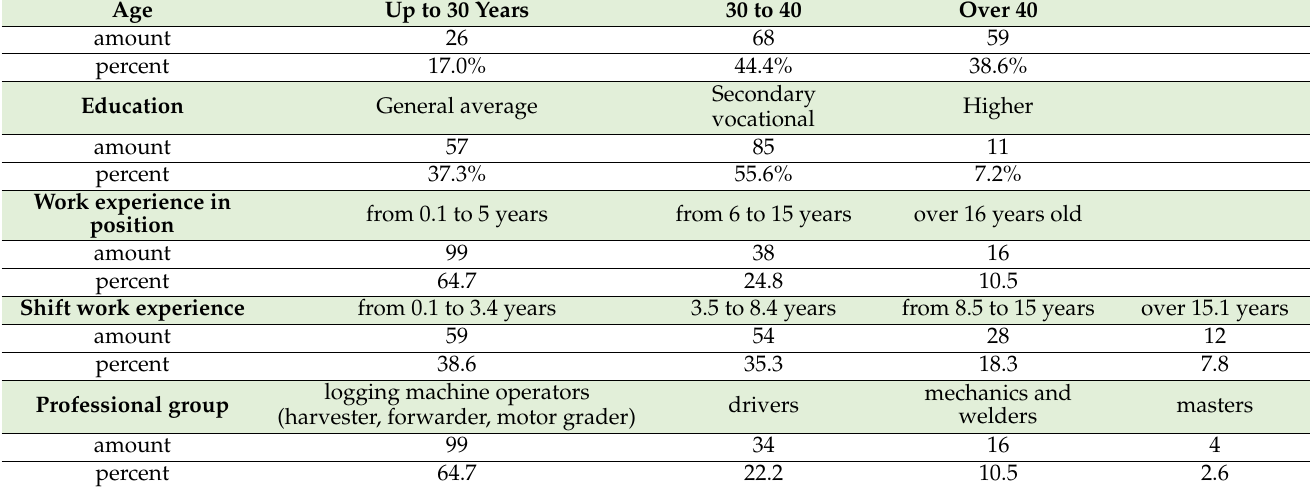
Table 1. Demographic characteristics of the